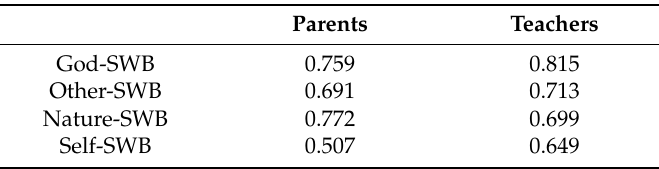
Table 4. Standardized Regression Weights from